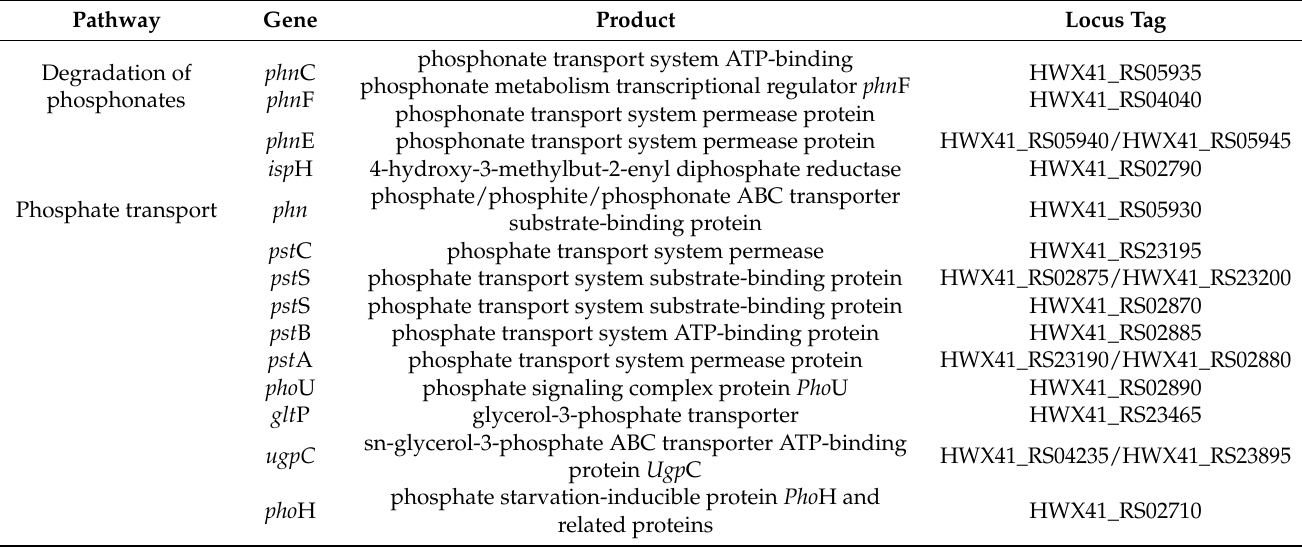
Table 3. Genes Involved in Phosphate Solubilization and